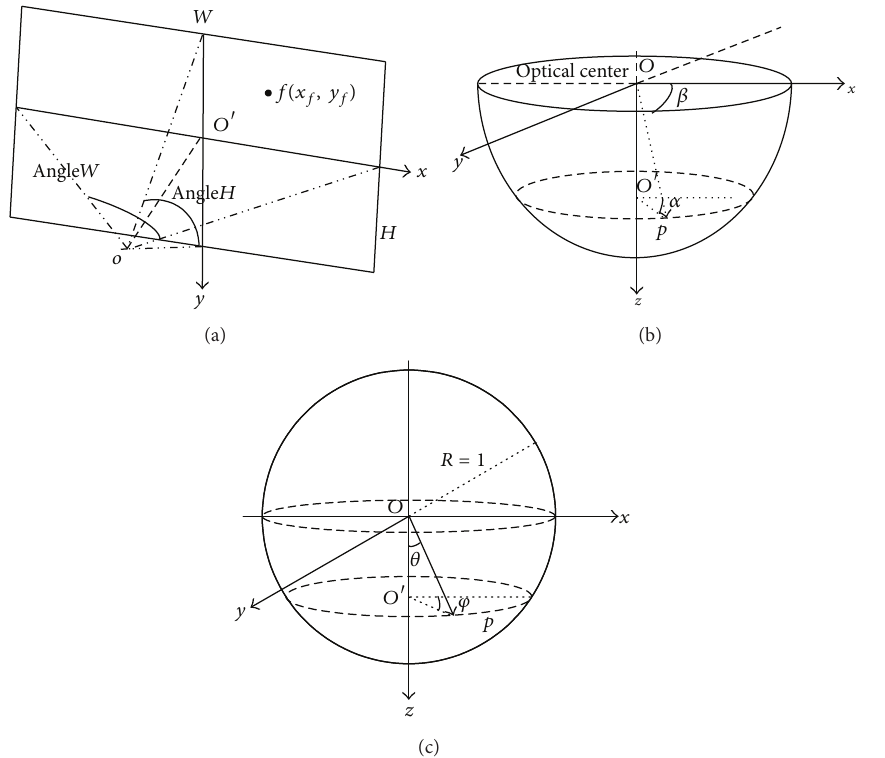
Figure 4: (a) Panoramic coordinate system, (b) PTZ camera coordinate system, and (c) PTZ image coordinate